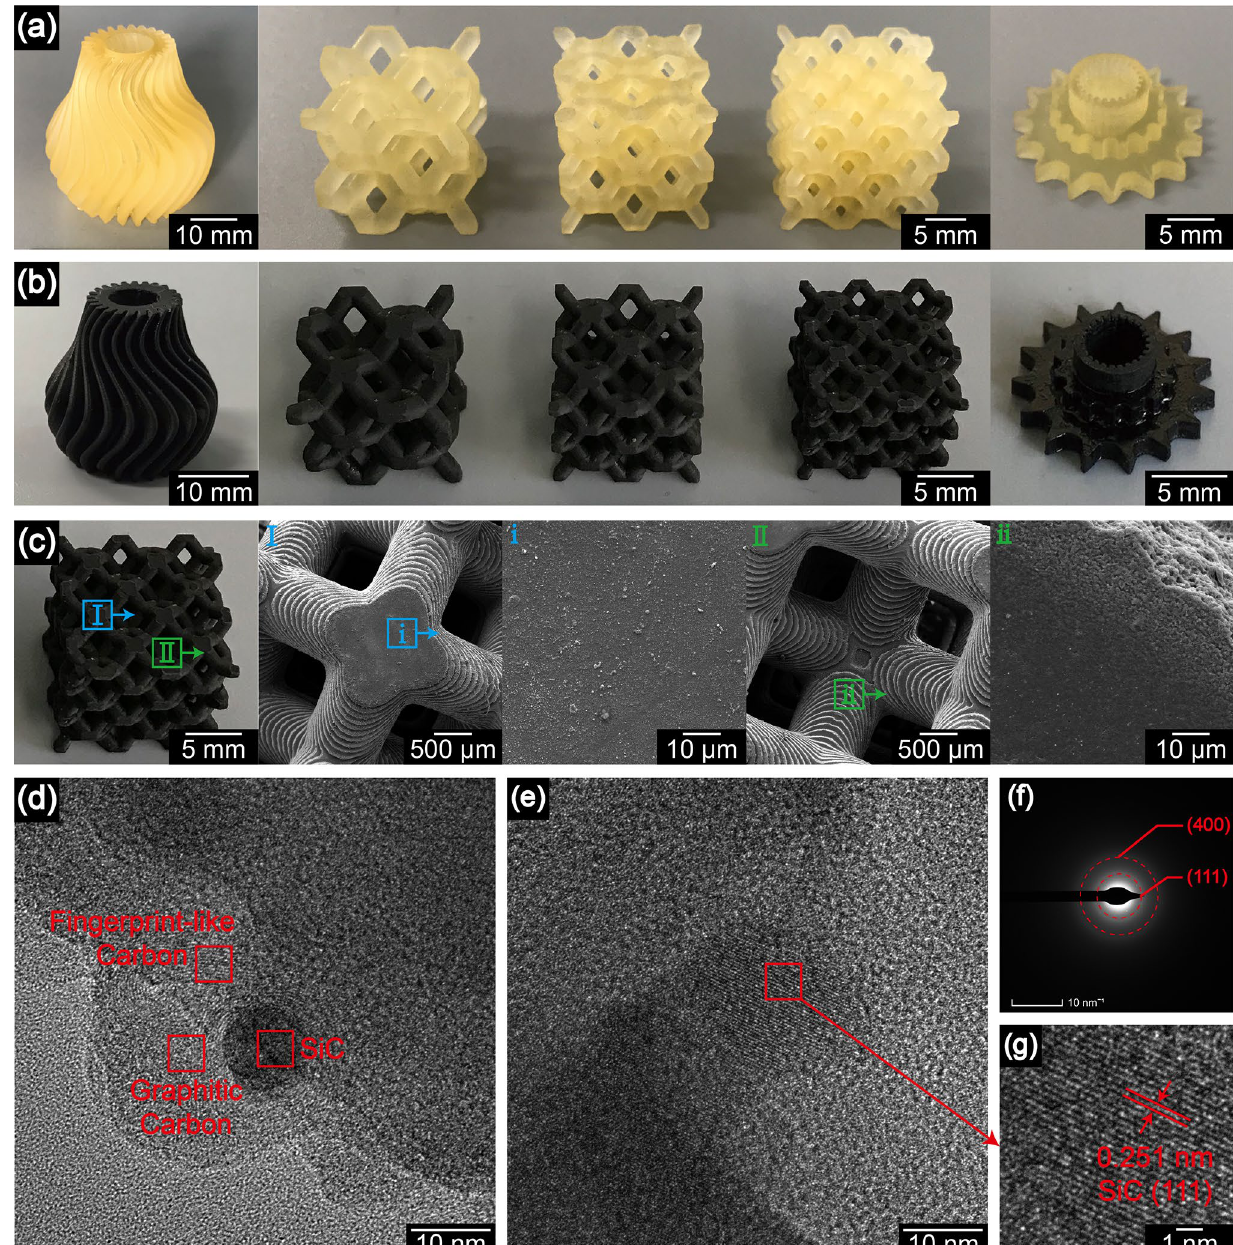
Fig. 3 Morphology and structures of 3D-printed green bodies and the corresponding pyrolytic ceramics: a typical structure of green bodies prepared by the DLP 3D printing; b corresponding structure of Si–O–C ceramic parts; c surface morphology SEM images of the ceramic cell structure; d, e TEM images; f selected area electron diffraction (SAED) image; and g lattice fringe of